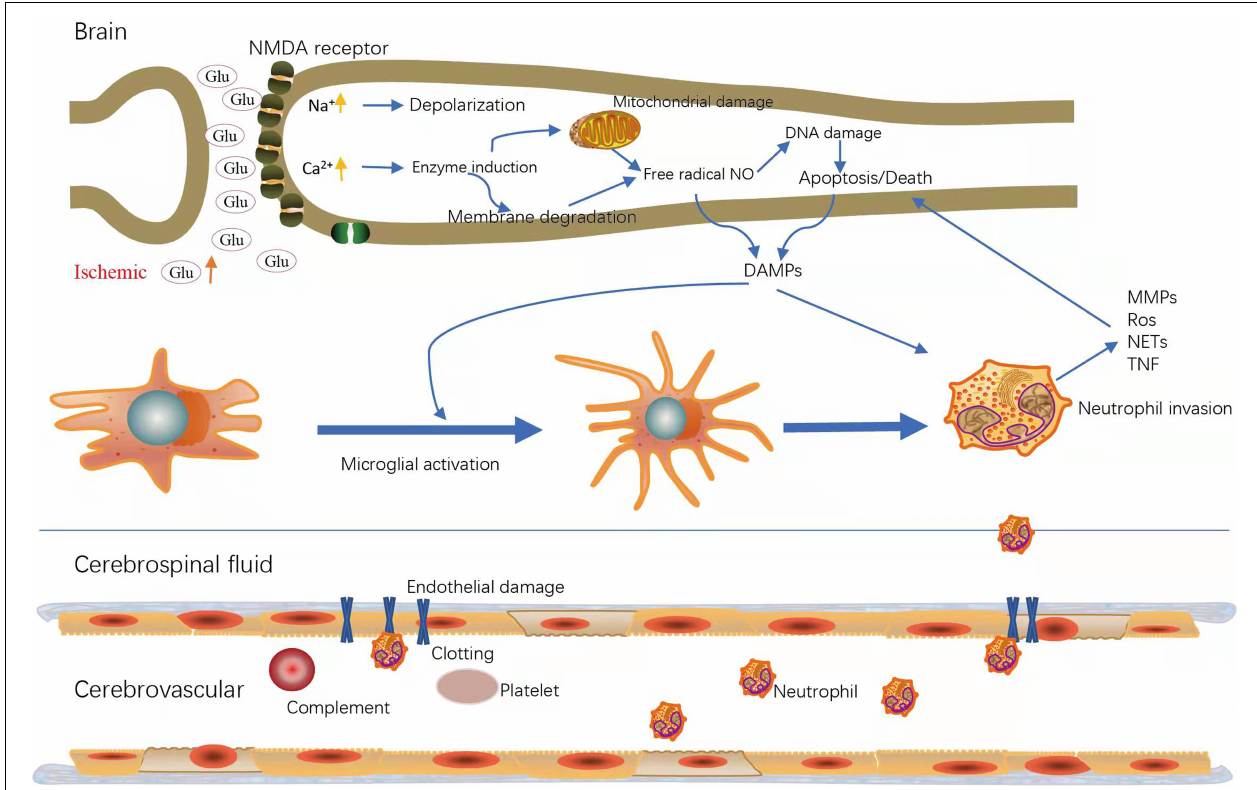
FIGURE 1 | Major active cells and molecules during ischemic stroke. Upregulation of glutamate (glu) and increased NMDA ( N -methyl-D-aspartate) receptors lead to intracellular calcium (Ca2+) and sodium (Na+) loading; Increased intracellular Ca2+ induce cell membrane degradation and mitochondrial damage, followed by apoptosis or death; DAMPs (Damage-associated molecular patterns) trigger microglial activation to release chemokines, which can induce neutrophil invasion; Ischemia leads to endothelial damage, resulting in increased vascular permeability and inflammatory cell migration. MMPs, matrix metalloproteinase; Ros, reactive oxygen species; NETs, neutrophil extracellular traps; TNF, Tumor Necrosis